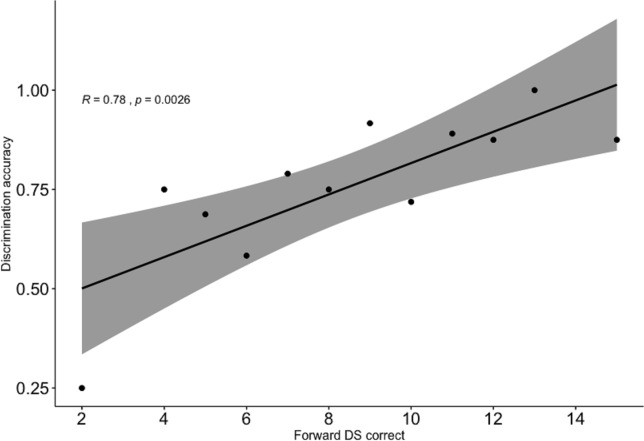
Correlation between discrimination accuracy and forward digit span task (aggregated participant results).Confidence interval is shown in grey.